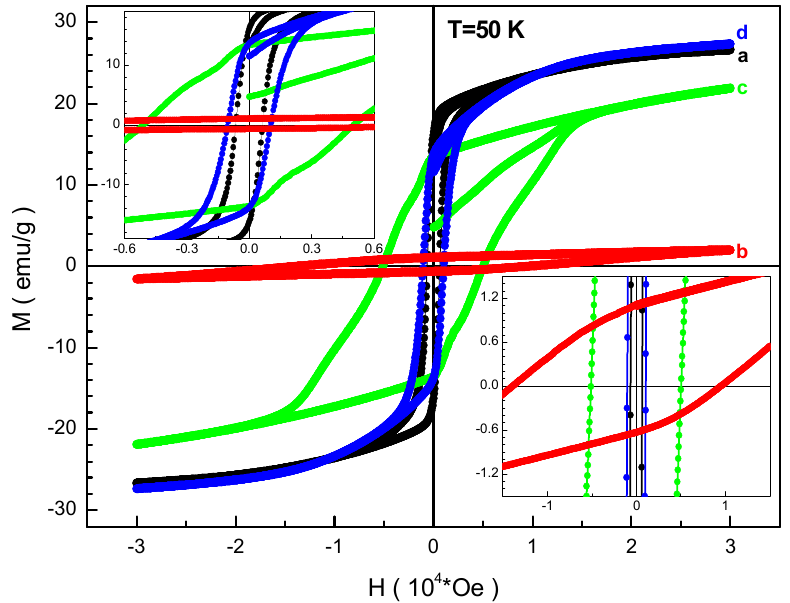
Figure 4. Field dependencies of magnetization at 50 K for the compositions ( a ) BaFe 5.84 Ga 6.16 O 19 , ( b ) BaFe 6.26 Al 2.27 Cr 3.47 O 19 , ( c ) BaFe 6.11 Al 1.56 Cr 2.17 Ga 2.16 O 19 , ( d ) BaFe 6.19 Al 1.25 Cr 1.57 Ga 1.74 In 1.26 O 19 .